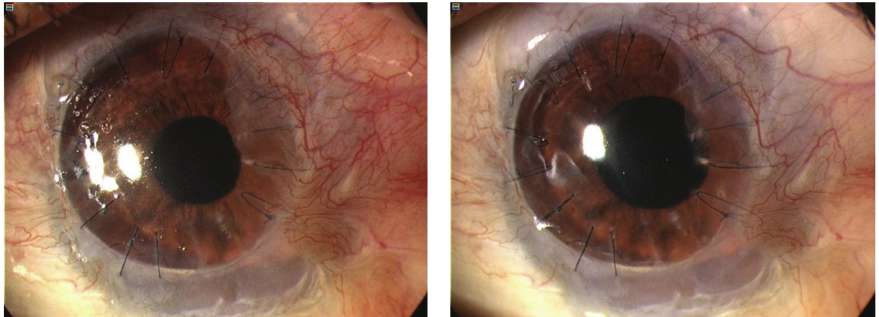
Figure 3: Representative case of corneal neovascularization treated with topical bevacizumab. Patient was a 19-year-old male who underwent penetrating keratoplasty combined with autologous limbal stem cell grafting for corneal leucoma after alkali burn. The baseline photograph shows active neovascularization (NV) reaching donor graft (left). Three months after topical bevacizumab treatment, NV decreased and is held on corneal graft border (right).